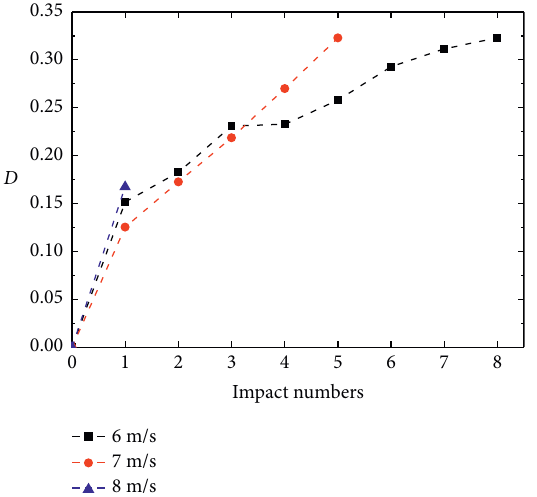
Figure 9: Relationships between rock damage and impact numbers with diferent impact